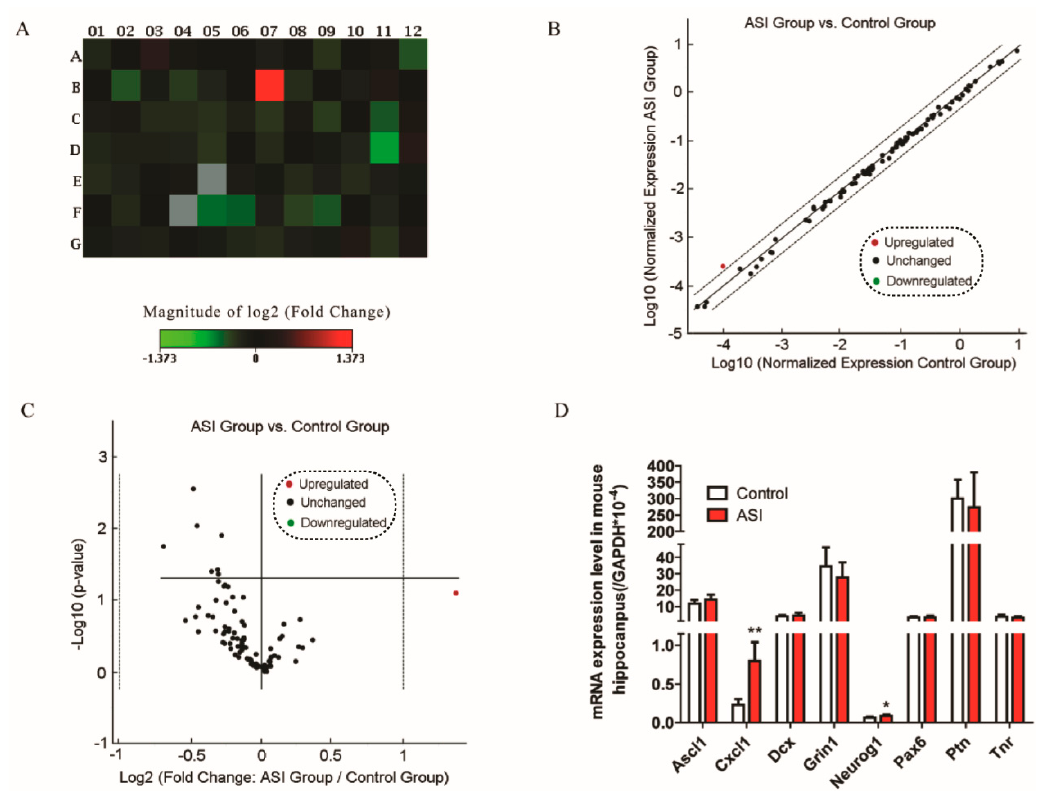
Figure 5. The effect of ASI (25 mg/kg) on eighty-four neurogenesis related genes. ( A ) The heat map provides a graphical representation of fold change between two groups overlaid onto PCRarray plate layout; ( B ) The scatter plot compares the normalized expression of every gene on the array between two groups by plotting one against another to quickly visualize gene expression changes. The central line indicated unchanged gene expression; ( C ) The volcano plot displays statistical significance versus fold-change on the y - and x -axes, respectively, enabling identification of genes with significant changes; ( D ) Verification of mRNA expression levels in mouse hippocampus; n = 6/group. * p < 0.05; ** p < 0.01. The data are presented as mean ± SD.